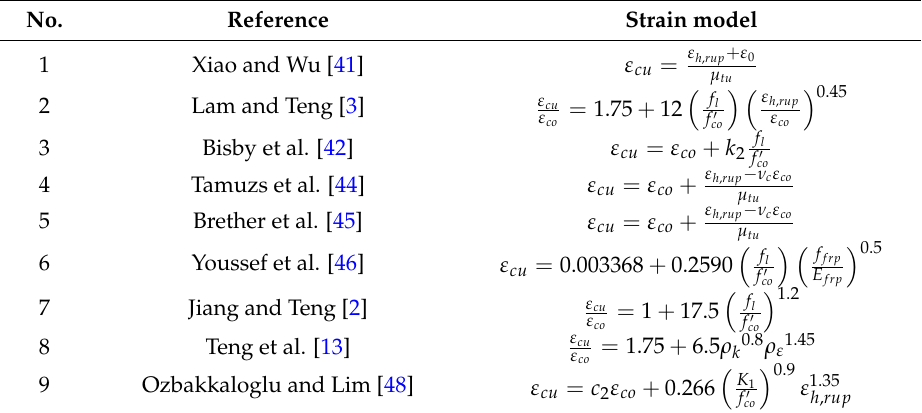
Table 8. Eleven representative ultimate strain